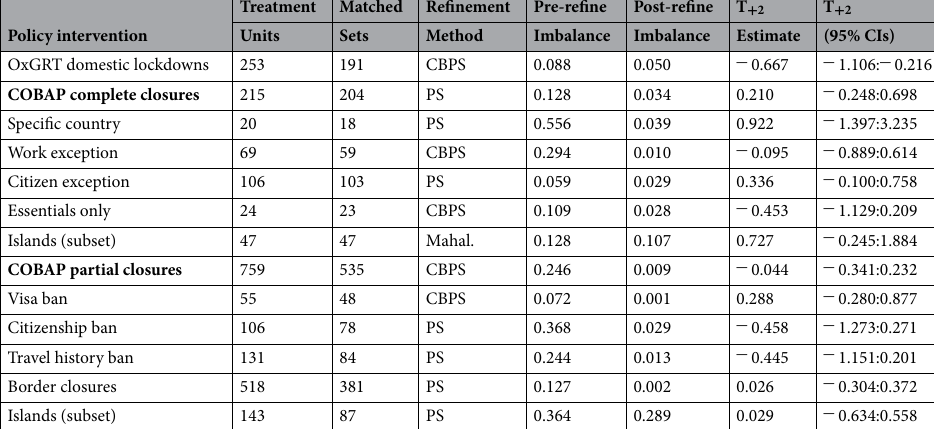
Table 1. Summary of model efficiency and results by general and specific policies. The first two columns show the total number of treated units available for analysis and then the number remaining after matching. Columns three through five report the refinement method used for each model as well as the reduction of imbalance between a model without refinement and after refinement, with 0 representing optimal balance across all variables. Finally, column six reports the T + 2 estimate, and column seven provides the 95% confidence